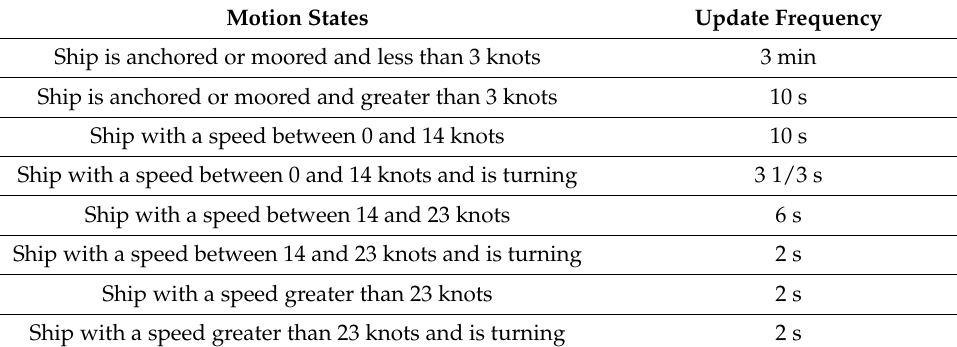
Table 2. Update frequency of Class-A ship dynamic information [33].